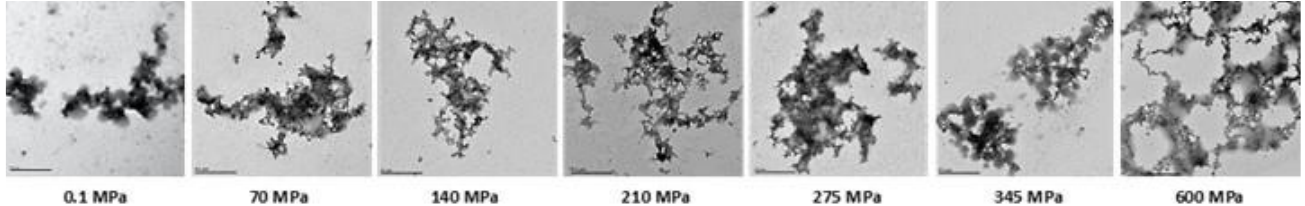
Figure 6. TEM images of control (0.1 MPa) and pressure-treated mealworm protein samples. Magnification factor: 10 K; observation scale: 0.5 µm.